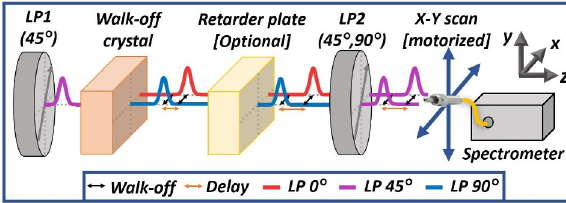
Fig. 1. Scheme of the spatiotemporal characterization technique introducing the walk-off in the horizontal direction